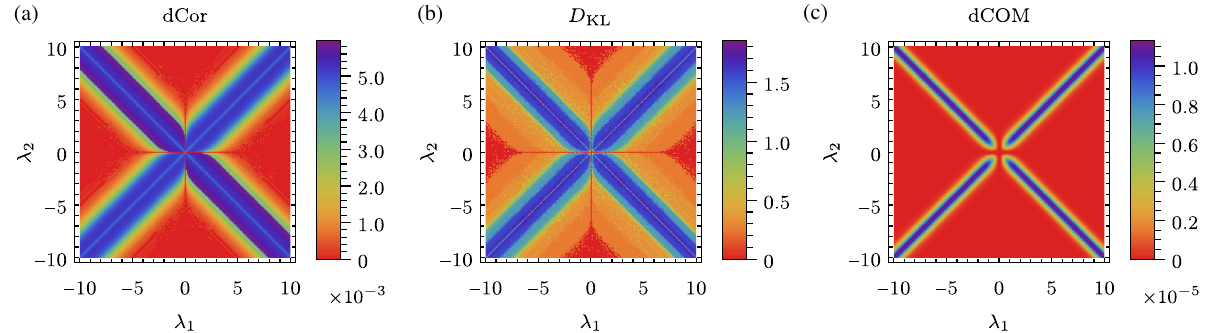
FIG. 9. Properties of the renormalized disorder distribution as a function of the coarse-graining rule for the case of the random dilute Ising chain. The RG rules are parametrized by λ 1 , λ 2 , as before. (a) The distance correlation (see the main text) dCor between renormalized distributions of two neighboring NN couplings. The couplings are uncorrelated if and only if dCor vanishes; compare with Fig. 4(a). (b) An alternative measure of correlations is the Kullback-Leibler divergence D computed between the product of marginal KL distributions of neighboring couplings and their joint distribution (c) The K ⊥ 0 center of mass of the disorder distribution dCOM (see the main text and Fig. 8). Note that all those quantities vanish when MI is